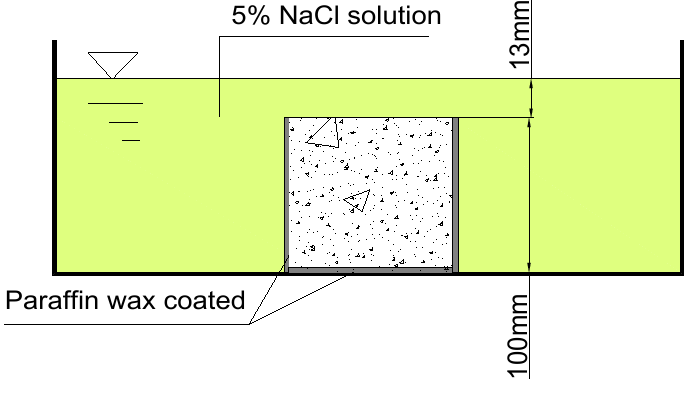
Figure 9. Schematic diagram of 5% NaCl solution immersion of concrete